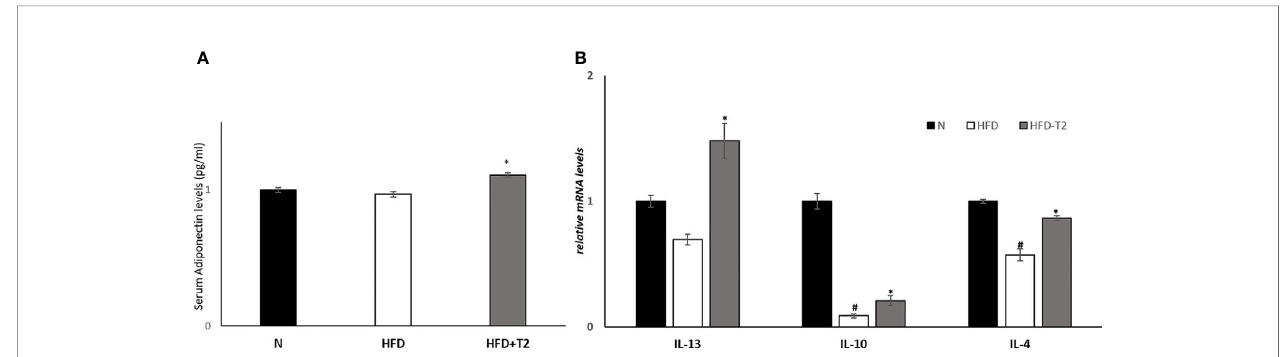
FIGURE 4 | Effects of T2 administration on adiponectinserum levels and on expression of IL-13, IL-10 and IL-4 in vWAT. (A) Adiponectin was detected by a competitive Enzyme Linked-Immunosorbent Assay (ELISA) in serum of N, HFD, and HFD-T2 rats; (B) RT-qPCR analysis of IL-13, IL-10, IL-4 in vWAT of N, HFD, and HFD-T2 rats. Values are means ± SEM of fi ve independent experiments (n = 5), *P < 0.05 vs. HFD; # P < 0.05 vs. N. N: rats receiving a standard diet for 14 weeks; HFD: rats receiving a HFD for 14 weeks; HFD-T2: rats receiving a HFD for 14 weeks with a daily administration of T2 during the last 4